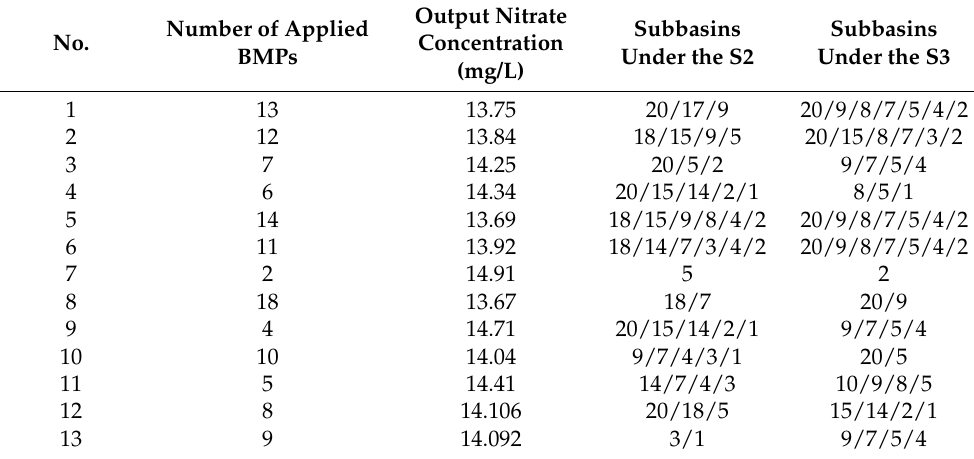
Table 9. The information extracted from MOPSO.